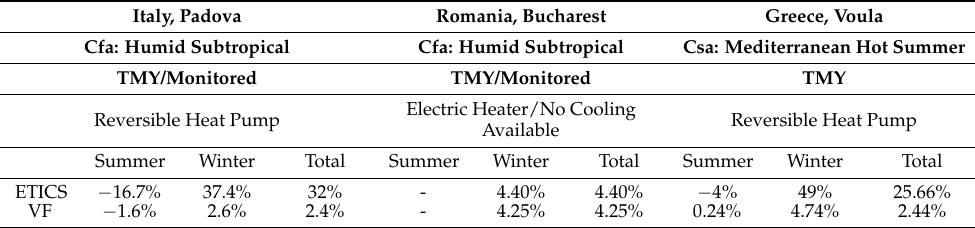
Table 2. Energy savings with InnoWEE passive solutions for all demonstration